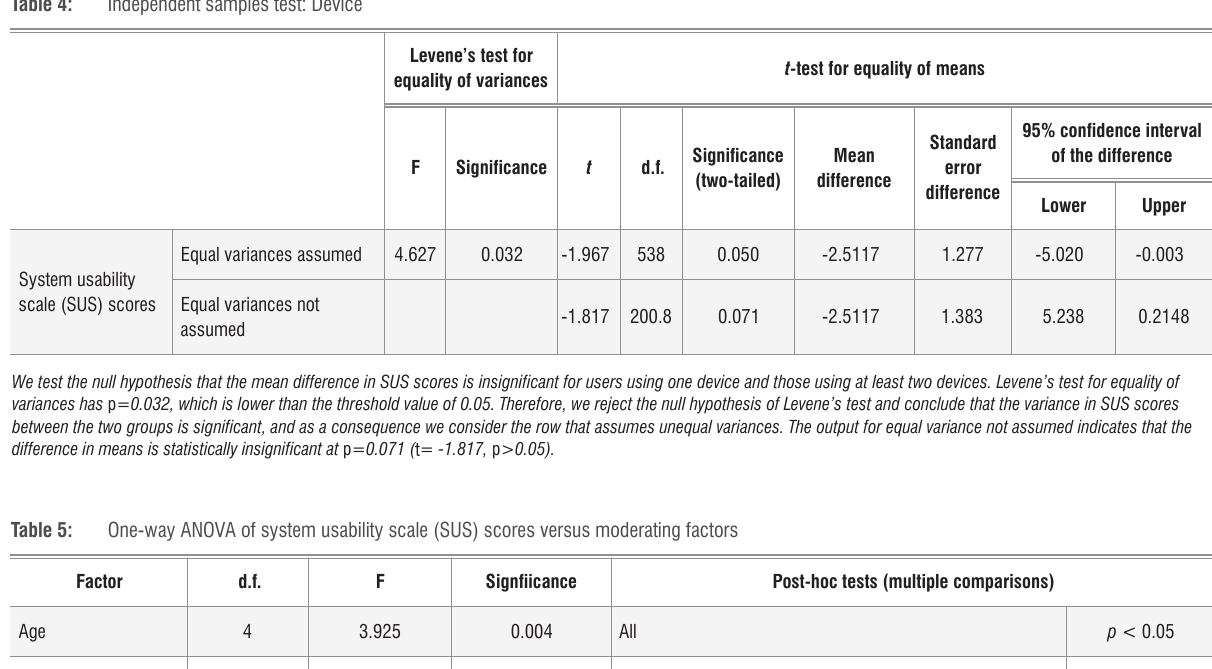
Table 4: Independent samples test: Device